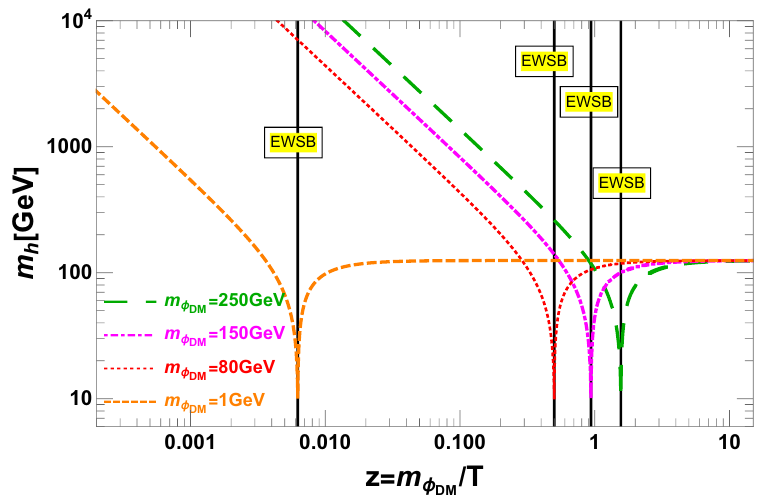
Figure 1 . Variation of the SM Higgs boson mass with z for different scenarios, Scenario-1 to Scenario-5 . The different scenarios correspond to m φ = 1 GeV for Scenario-4,5 m φ DM